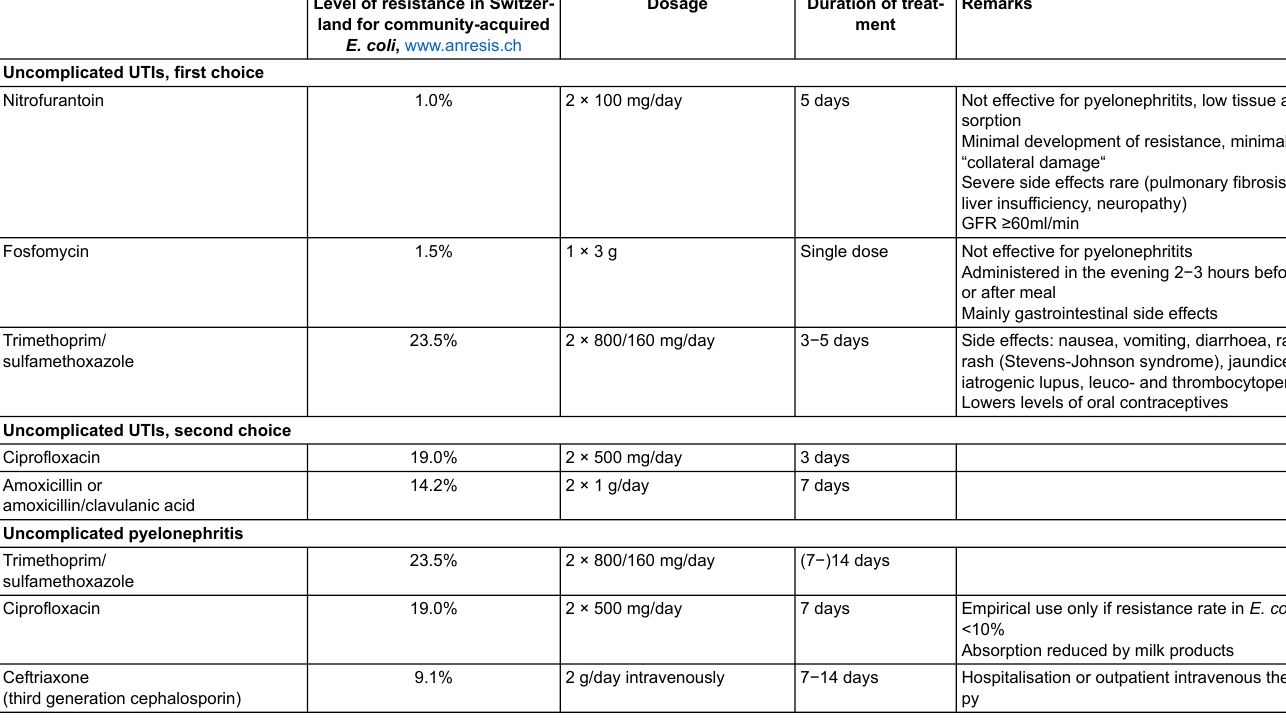
Level of resistance in